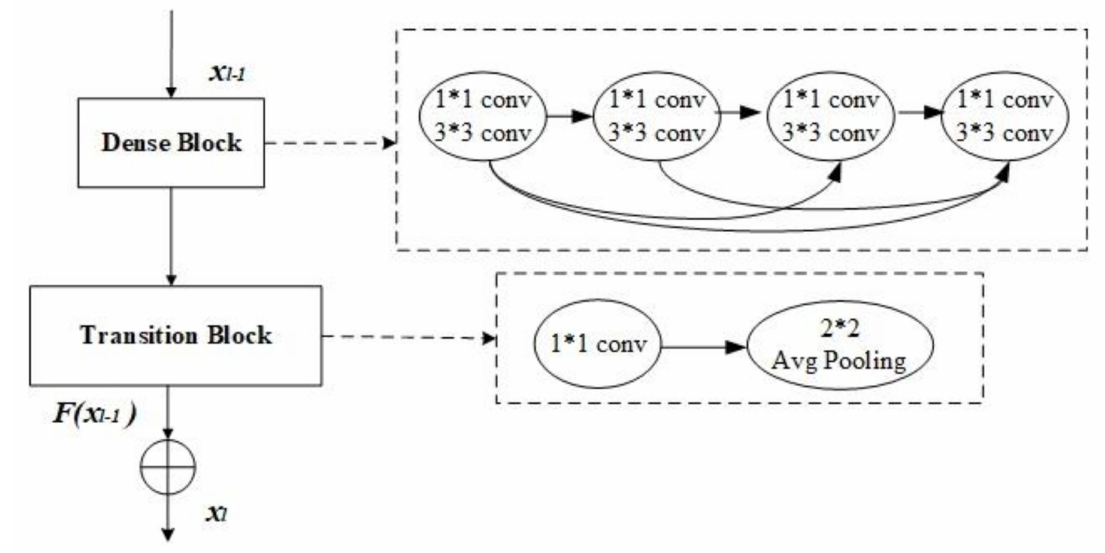
Figure 2. Architecture of the dense blocks and transition blocks. The “ ⊕ ” represents element-wise addition.